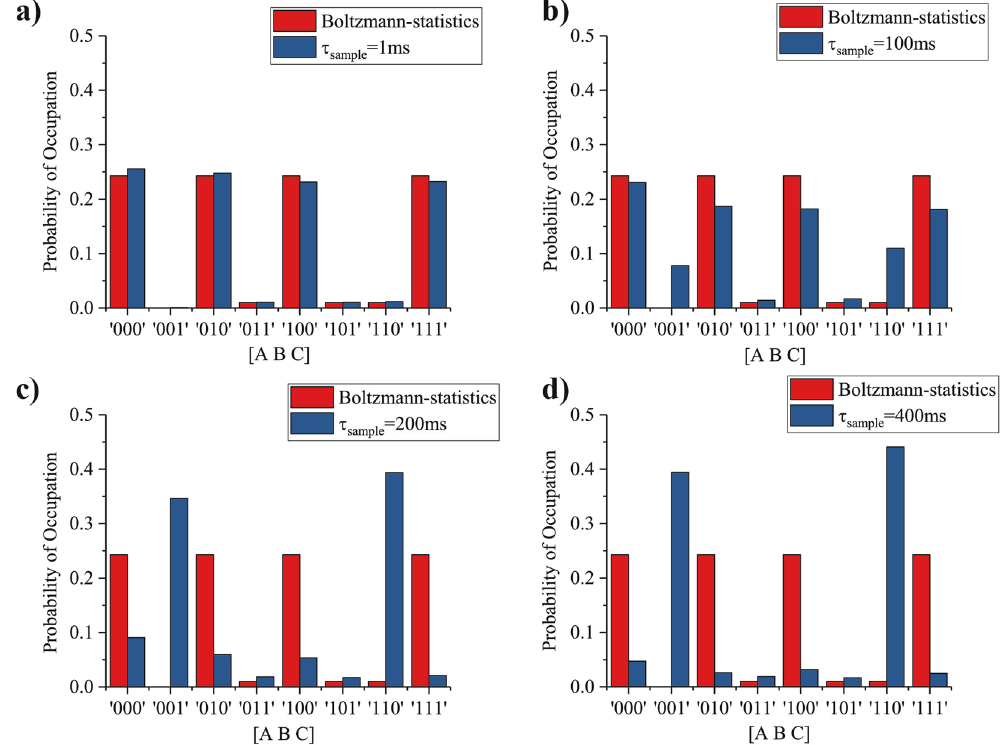
Figure 4. Sampling time. The sampling time τ sample is systematically varied from 1 ms to 400 ms while maintaining a constant retention time of τ N = 200 ms for each of the 3 p-bits. This is done by changing the user defined delay τ D in Algorithm 2. When τ sample = 1 ms, sampling is done much faster than the p-bit retention time and for this case steady-state statistics are well-described by the Boltzmann Law. As τ sample is increased to 100 ms becoming comparable to the retention time of p-bits, two erroneous states 001 and 110 get highlighted more. When τ sample is further increased to 200 ms the system completely breaks down. This trend repeates for = 400 τ sample